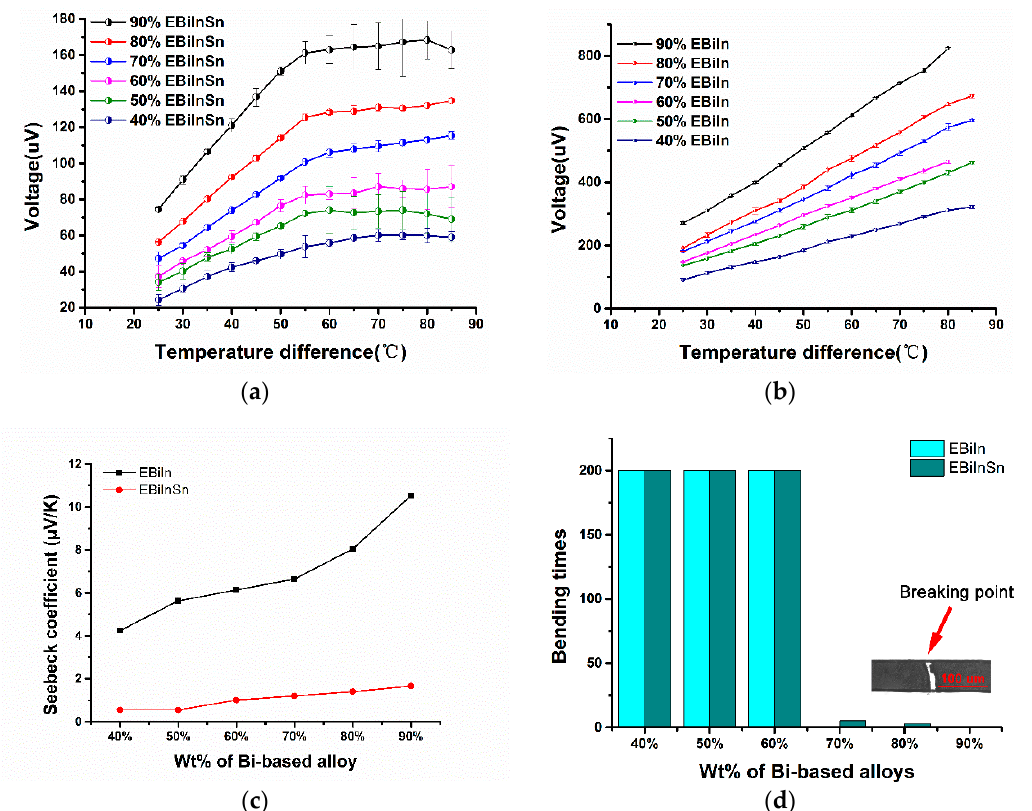
Figure 5. ( a ) Calibration curve of thermocouples with different ratios of EBiInSn. ( b ) Calibration curve of thermocouples with different ratios of EBiIn. ( c ) Seebeck coefficients of thermocouples calculated by the data of the calibration curve. ( d ) Results of bending test of thermocouples with different ratios of Bi-based alloy (the experimental bending test videos (S3 and S4) are included in the Supplementary Materials).